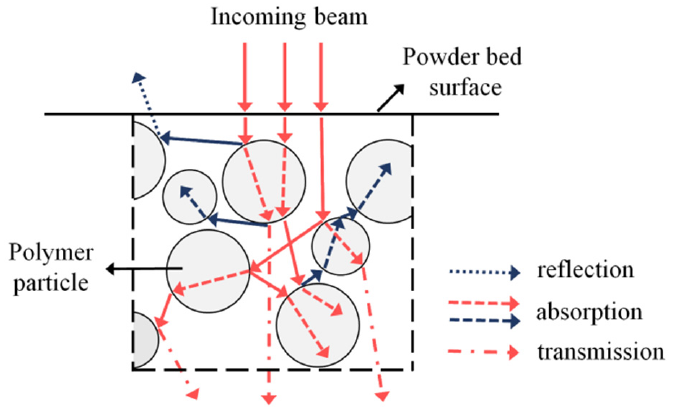
Figure 4. Graphical representation of the interaction of the laser beam with the powder bed, with multiple reflection/absorption events. Reproduced with permission from [75].